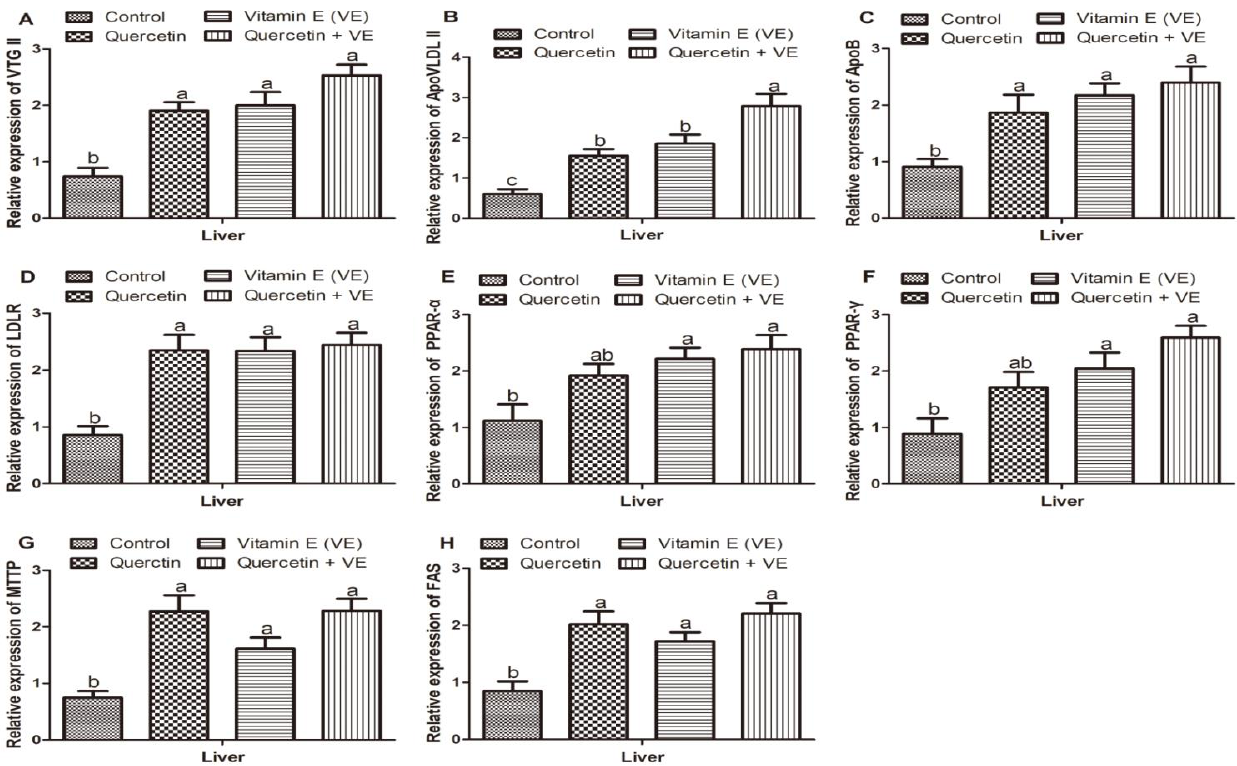
Figure 9. Effects of quercetin, vitamin E, and quercetin + vitamin E on the expression of mRNAs related to yolk precursor synthesis in the liver of aging breeder hens. Levels of expression of VTG II ( A ), ApoVLDL II ( B ), ApoB ( C ), LDLR ( D ), PPAR- α ( E ), PPAR- γ ( F ), MTTP ( G ), and FAS ( H ). Bars without the same letter differed significantly ( p < 0.05).